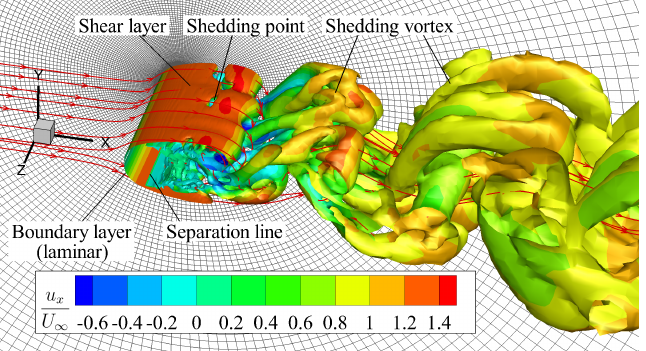
Figure 5. Flow field structure over a circular cylinder at Re D = 3900. (isosurface: Q